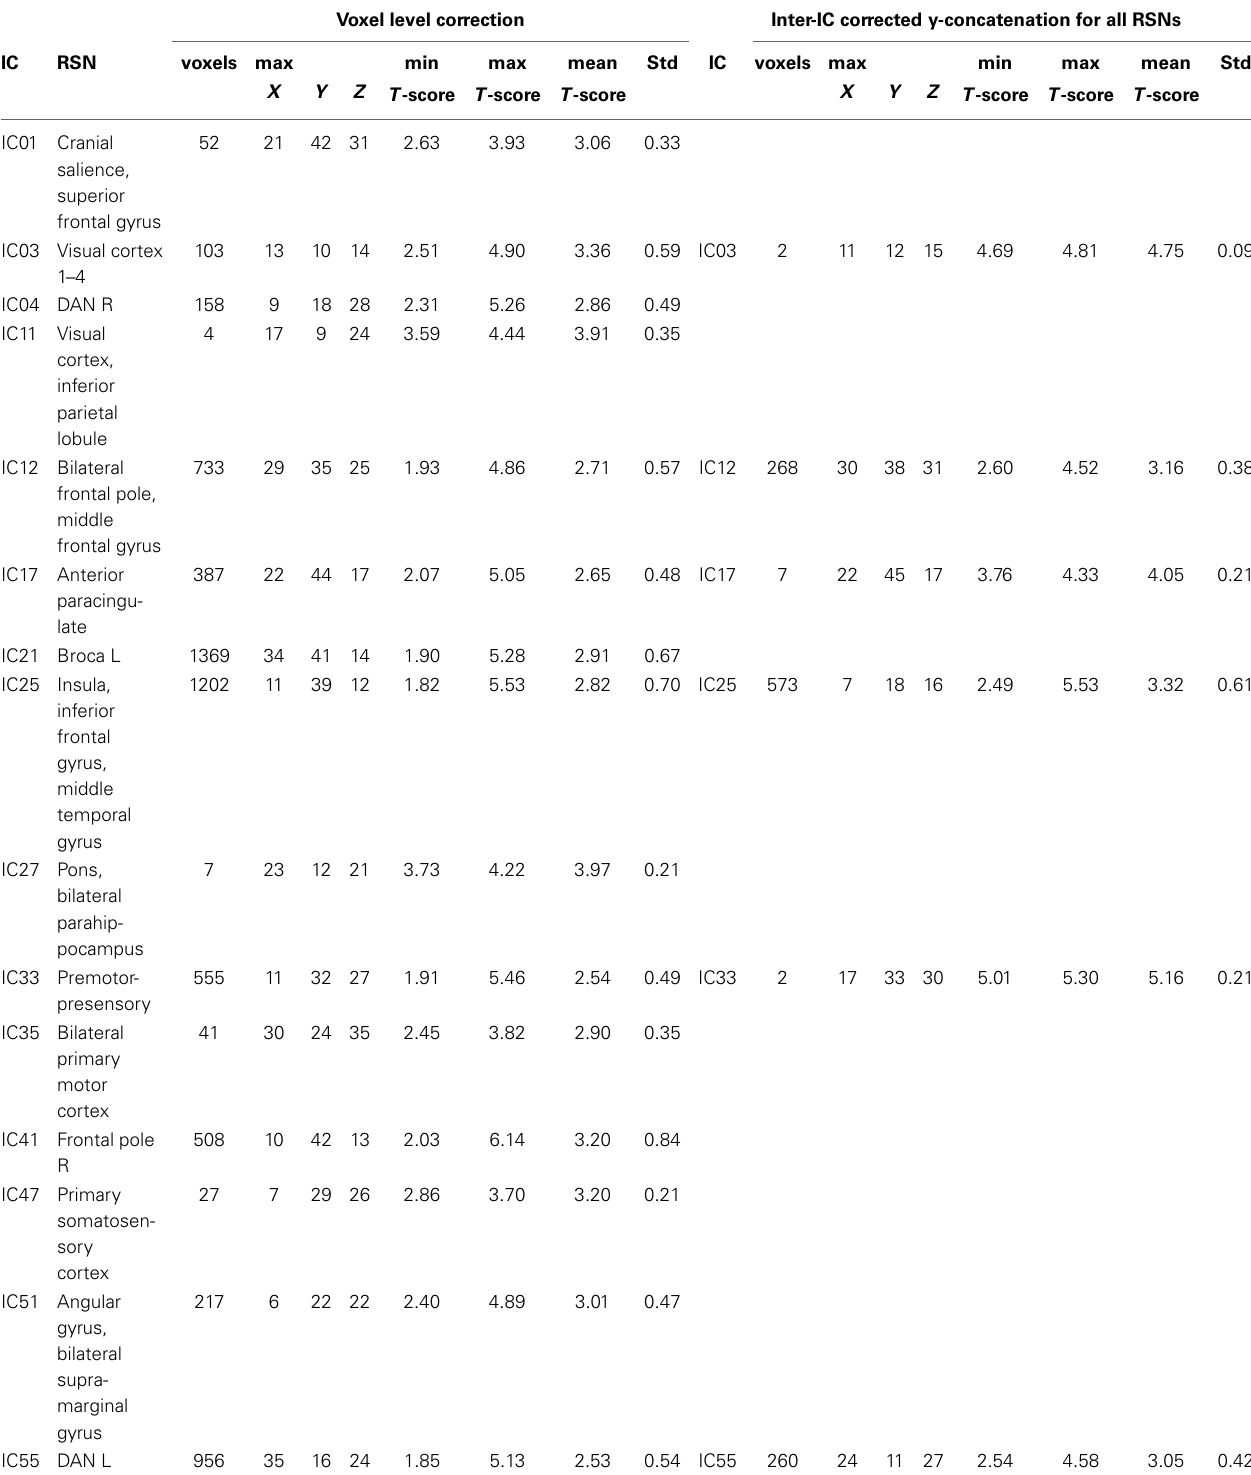
Table 1 | Functional brain regions showing increased functional connectivity in patients with bvFTD compared to healthy controls. Voxel level correction Inter-IC corrected y-concatenation for all